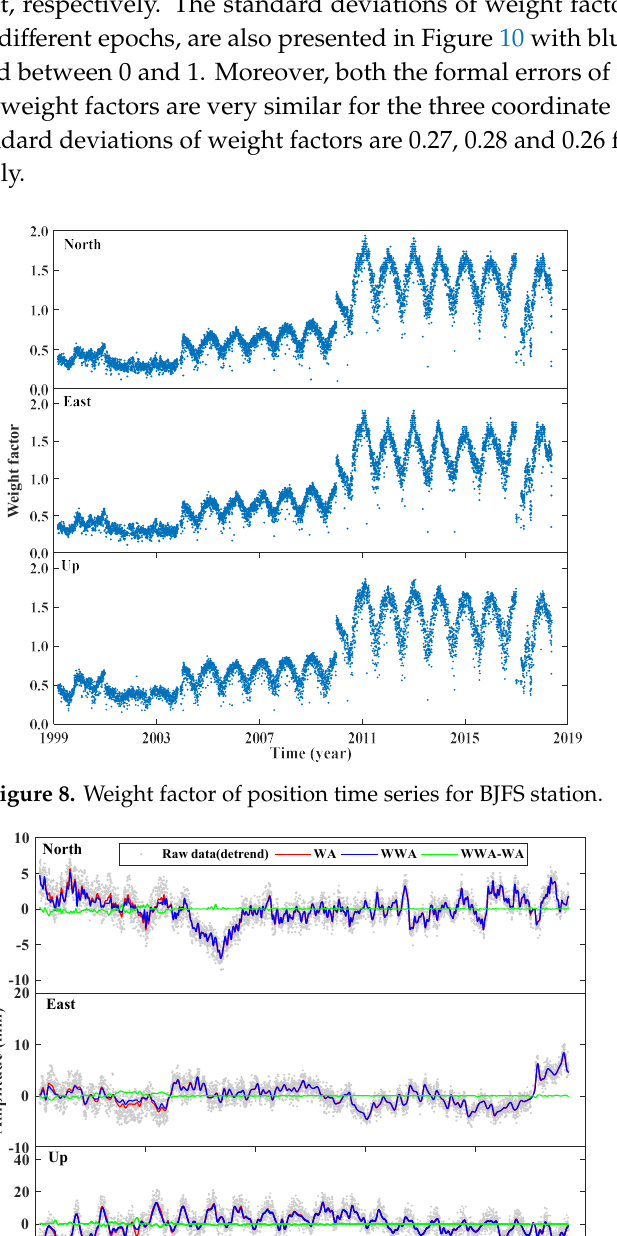
Figure 7. Periodic power spectrum of reconstructed component of each layer. Table 1. Correlation coefficients between original time series and reconstructed component of each wavelet layer